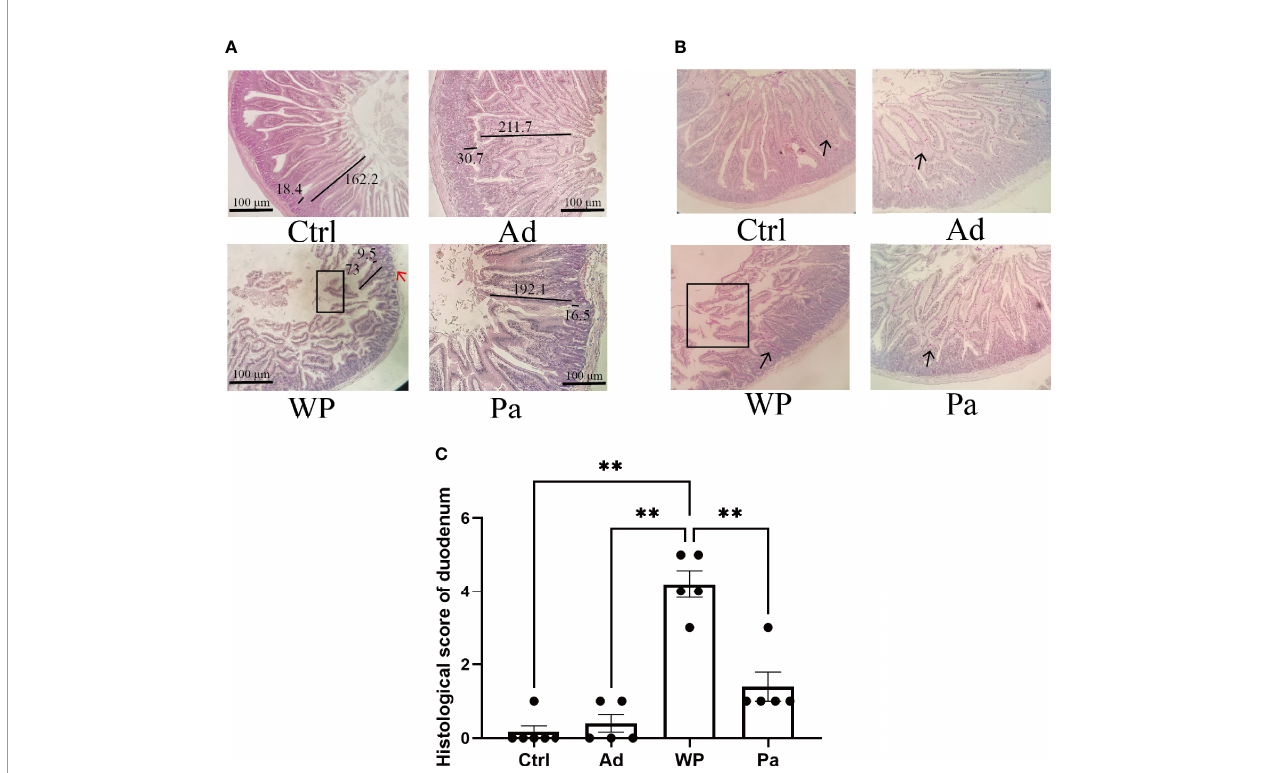
FIGURE 2 | (A) Hematoxylin and eosin-stained duodenum in non-immunized negative control (Ctrl), group injected with adjuvant (Ad), group injected with gluten and adjuvant (WP), and treated with Pediococcus acidilactici XZ31 (Pa). (B) Periodic acid – Schiff-stained duodenum in Ctrl, Ad, WP, and Pa. (C) Histological analysis of the duodenum. n = at least 5 mice per group. The results are presented as the mean value ± standard error of mean. The asterisk indicates a statistically signi fi cant difference ( P <0.05). The stained gut sections were photographed with a Leica microscope at ×100 magni fi cation. The black box indicates shedding of the intestinal villus. The black line represents the villus height and crypt depth ( m m). The red arrow indicates muscle damage. The black arrows indicate goblet cells (red